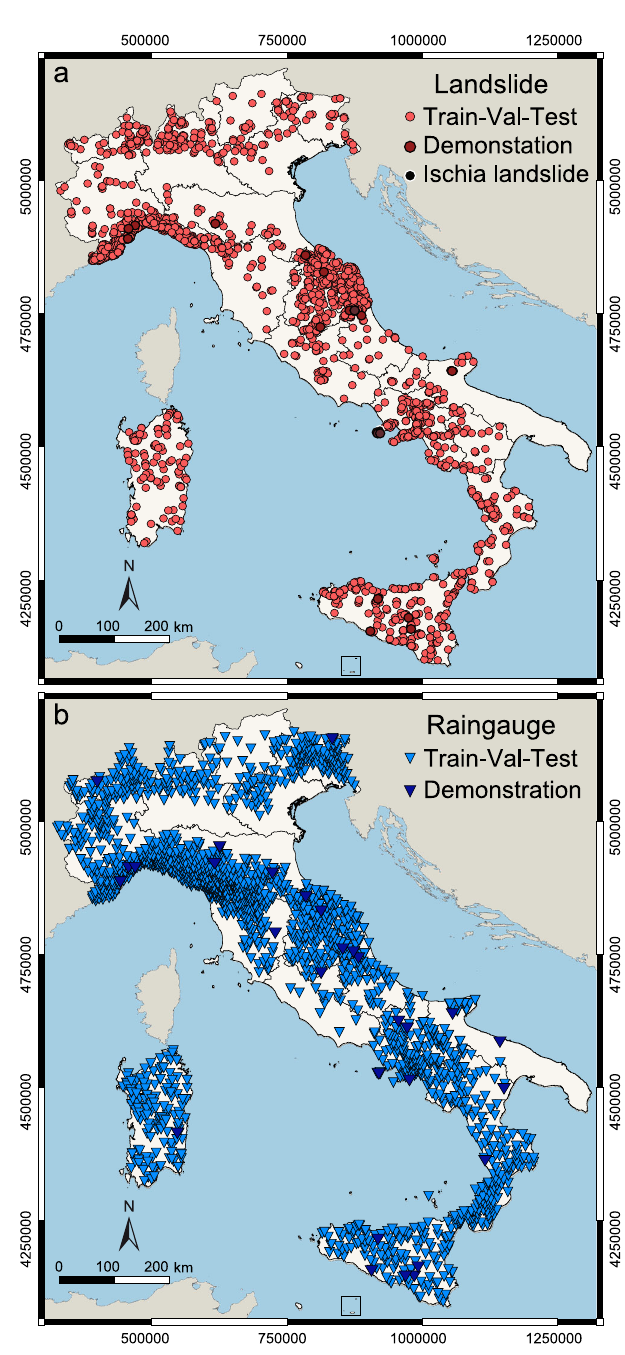
Fig.1|Locationoflandslideandraingaugedatausedinthestudy.a Mapshows locations of 2486 rainfall-induced landslides from February 2002 to December 2020 used in the work (red dots), including 14 landslides used to demonstrate the potentialoperationaluseoftheforecastingsystemdiscussedintheDemonstration section (dark red dots). Black dot shows location of the 26 November 2022, Casamicciola Terme landslide, Ischia Island, also used for demonstration. b Map shows locations of 2096 rain gauges (blue triangles) for which hourly rainfall records were available to us, of which 29 rain gauges (dark blue triangles) used to demonstratethepotentialoperationaluseoftheforecastingsystem.Inbothmaps, geographical and administrative boundaries credits are from the European Envir- onment Agency (EEA) and the Istituto Nazionale di Statistica